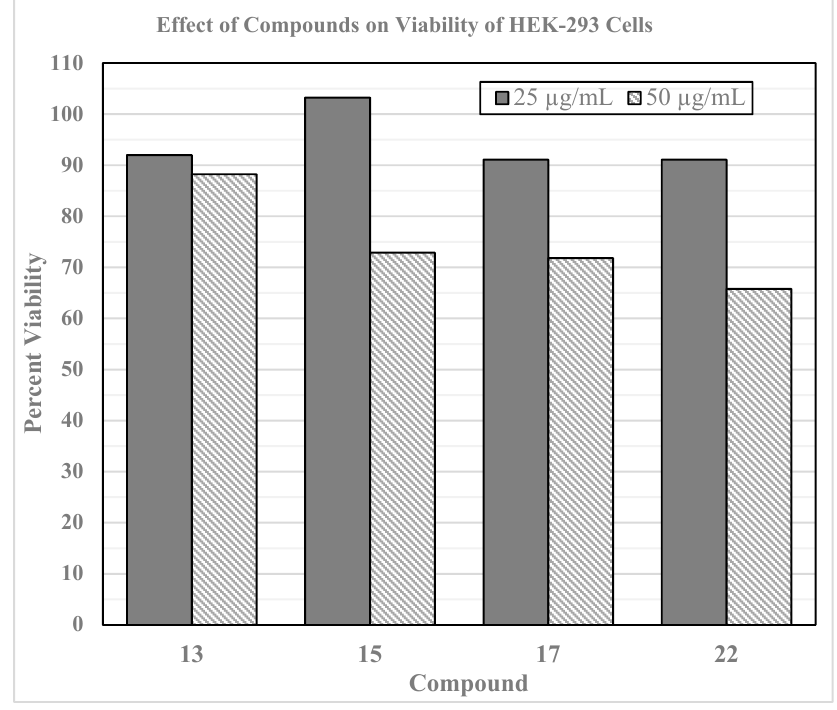
Figure 2 . Cytotoxic assay of active compounds on HEK293 cell line by using resazurin assay.